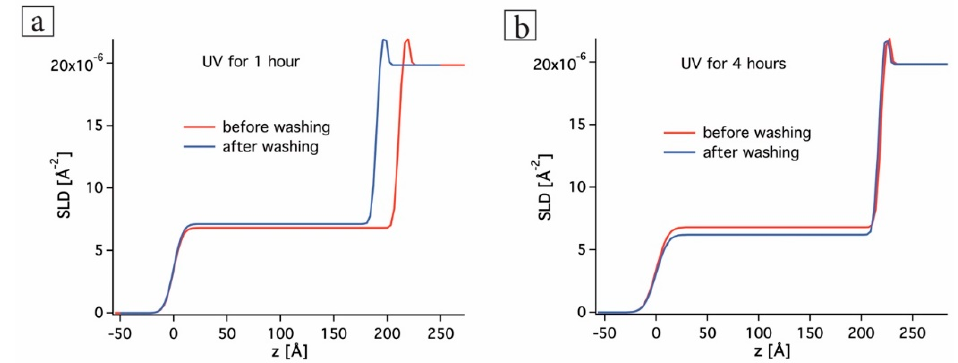
Figure 9. Electron density profiles of PS- h ν -PEO ultra-thin film UV-cleaved for 1 h ( a ) and 4 h ( b ) before (red lines) and after washing in ultra-pure water (blue lines).